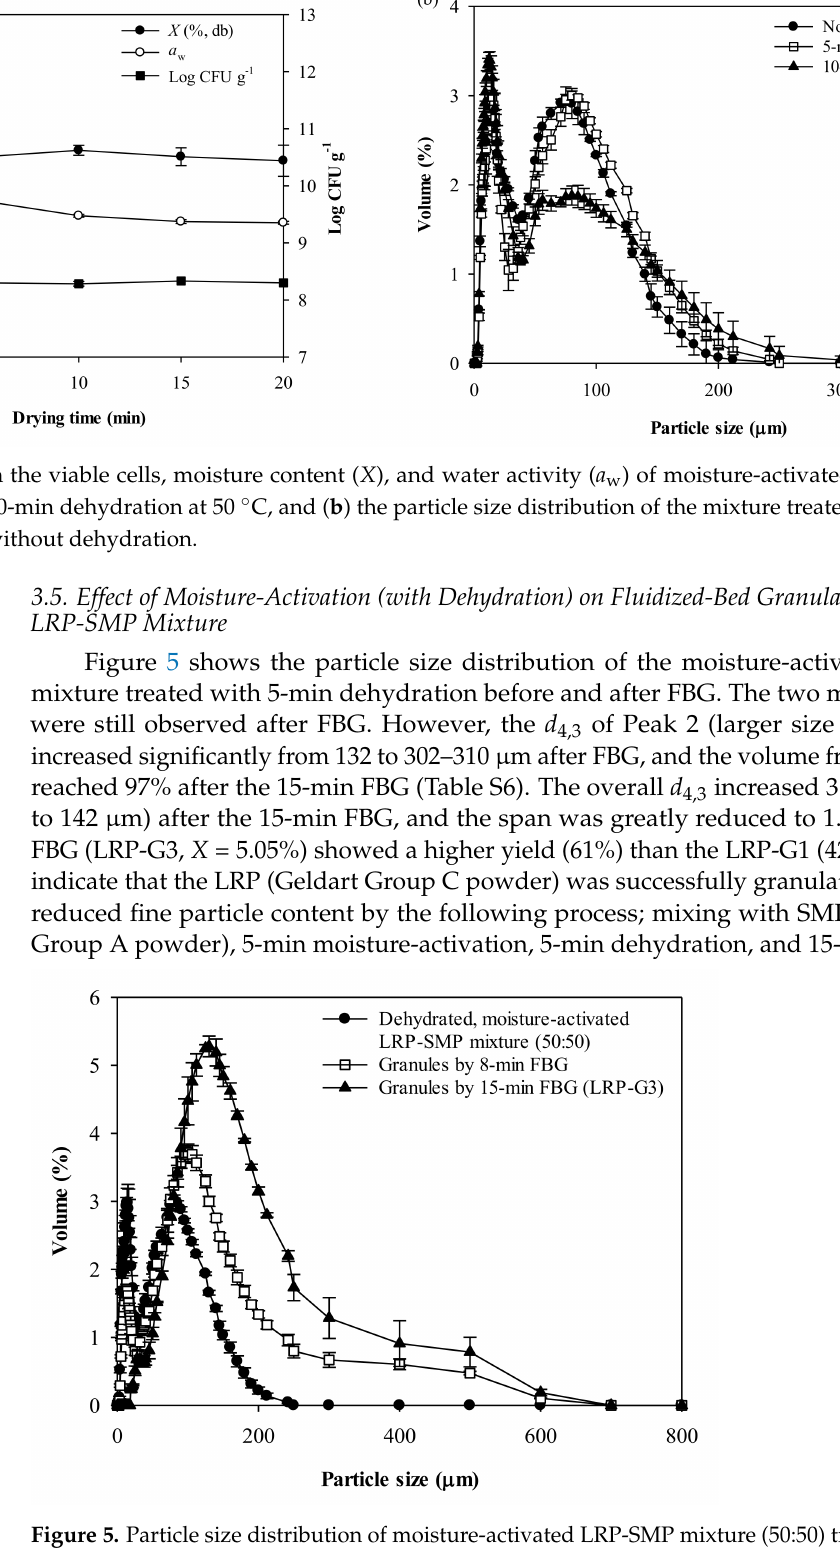
Figure 5. Particle size distribution of moisture-activated LRP-SMP mixture (50:50) treated with 5-min dehydration and the granules obtained by 8- or 15-min fluidized-bed granulation of the mixture. The granules from 15-min process were denoted as